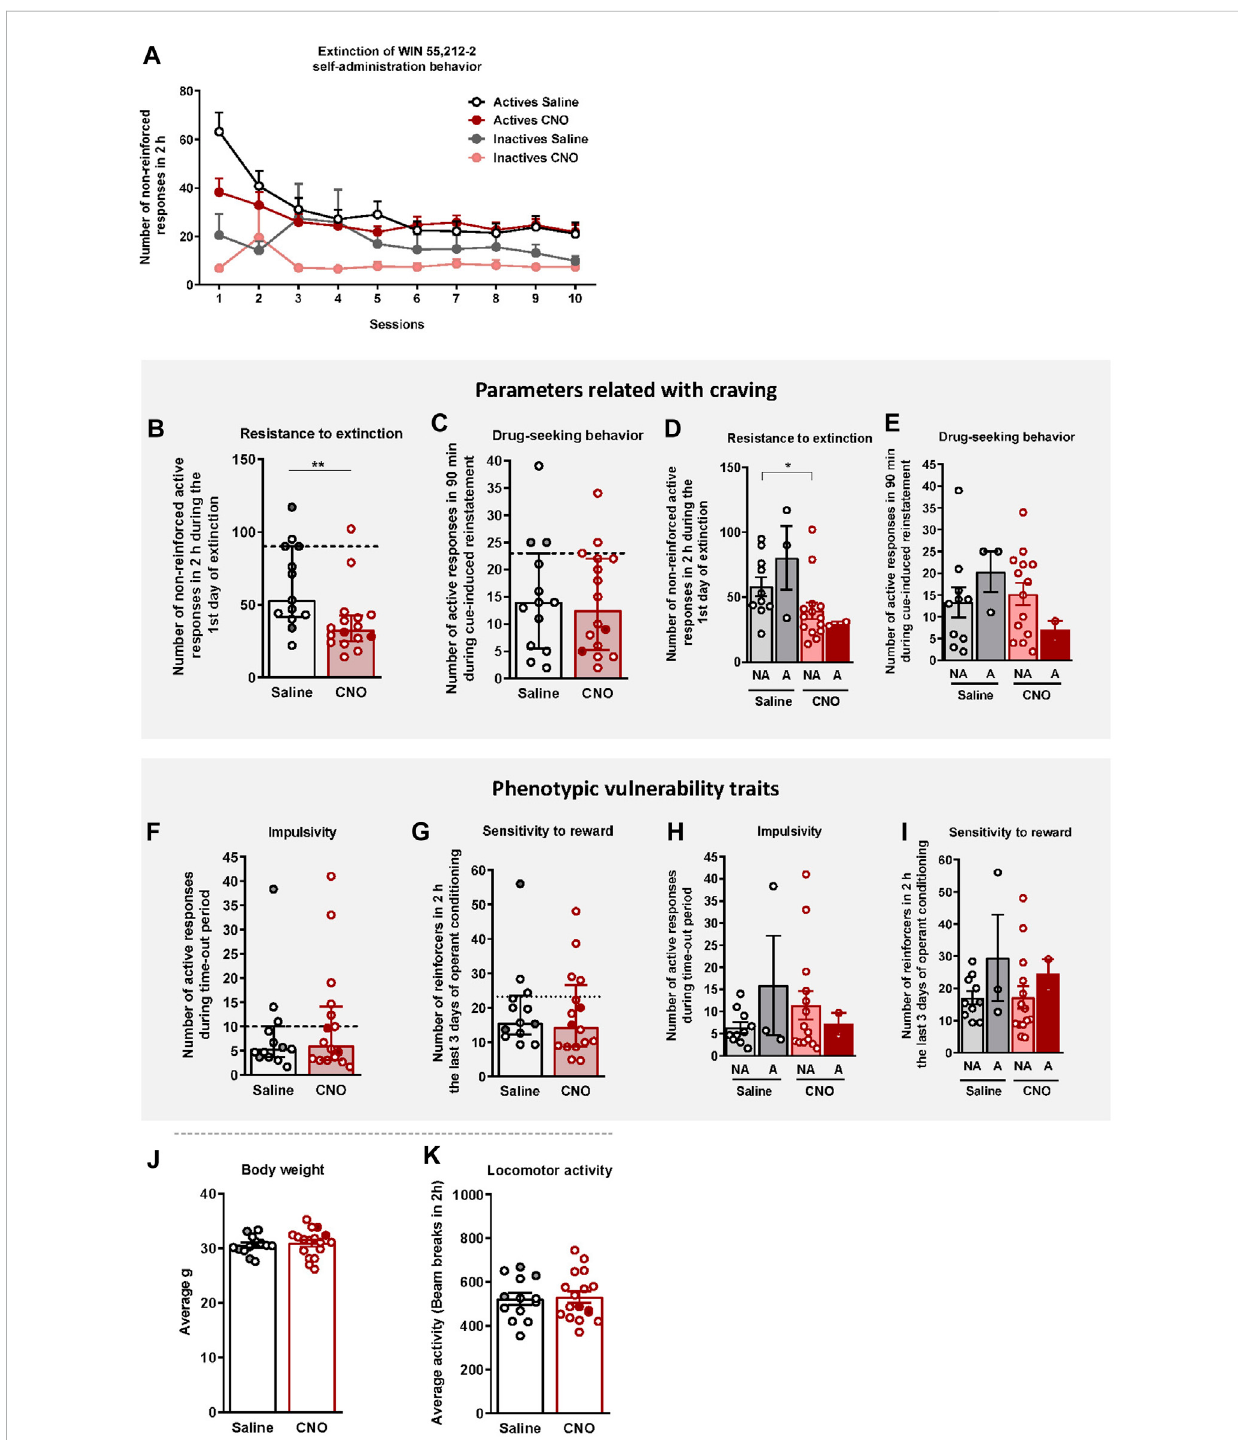
WIN 55,212 – 2 operant self-administration effects on two parameters related with craving and two phenotypic vulnerability traits to addiction-like behavior in mice. (A) Extinction pattern of the WIN 55,212 – 2 operant self-administration behavior (mean ± S.E.M., repeated measures ANOVA). (B – C) Behavioral tests of the two parameters related with craving (individual data with median and interquartile range): (B) Resistance to extinction: Number of responses to the active nose-poke during the fi rst 2-h extinction session is signi fi cantly higher in saline-compared to CNO-treated mice (U Mann- Whitney, ** p < 0.01). (C) Drug-seeking behavior measured by the cue-induced reinstatement after abstinence: Number of active responses performed duringthe90 mincue-induceddrug-seekingtestperformedafterextinction(Student ’ st-test).Thedashedhorizontallineindicatesthe75thpercentileof distribution of the group, used as the threshold to consider a mouse positive for one criterion. Addicted mice are represented in grey- and red- fi lled circles. (D – E) Behavioral tests of the parameters related with craving showing similar responses in cue-induced reinstatement between addicted and non-addicted mice (U Mann-Whitney), whereas a difference is observed between non-addicted mice in the 1st day of extinction (U Mann-Whitney, * p < 0.05) (individual data with mean ± S.E.M.). (F – G) Behavioral tests used to evaluate the two phenotypic traits considered to be factors of vulnerability